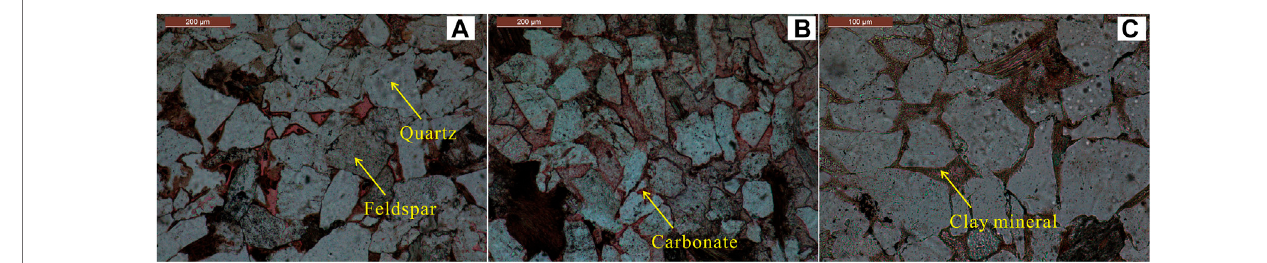
FIGURE 1 | SEM images of the study area.